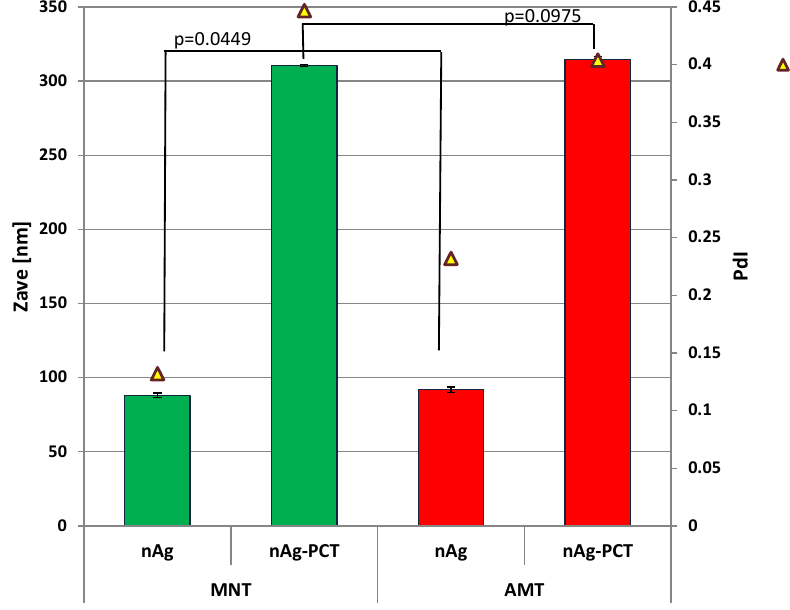
Figure 7. The average size (Z ave , nm) and polydispersity index (PdI) of phytogenic nanoparticles, estimated by Dynamic Light Scattering (DLS) measurements.